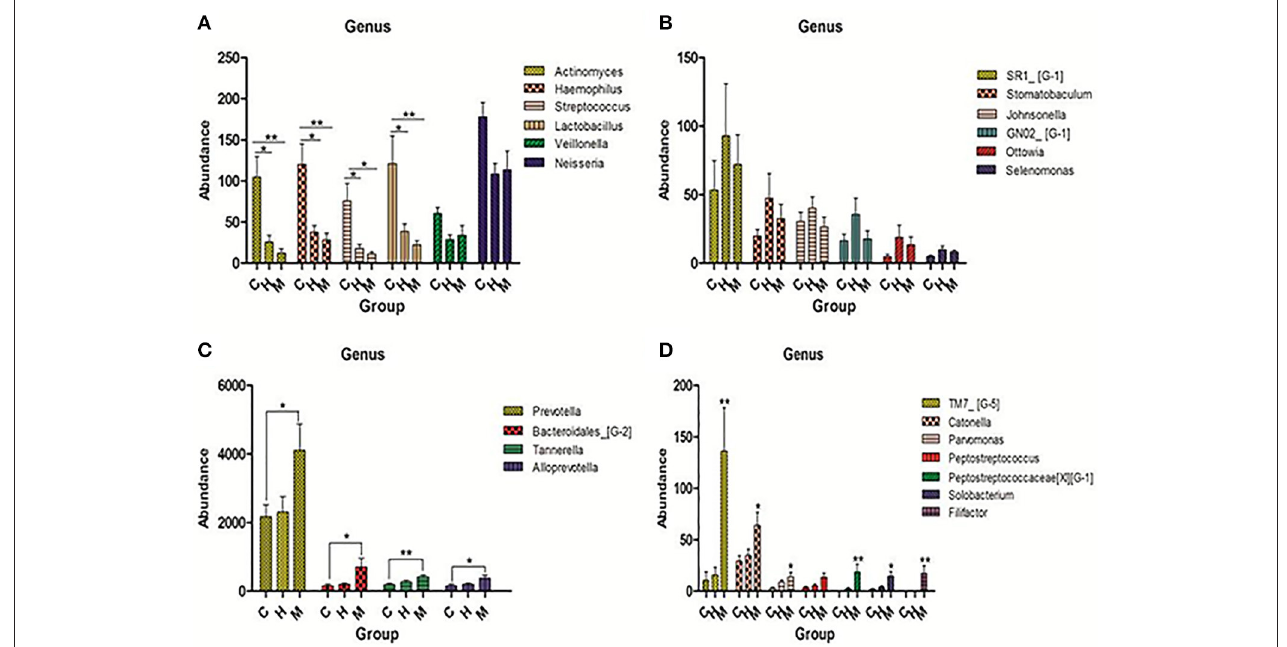
FIGURE 3 | Pick out 50 genera which were ranked top in the total genera and then analyzed the predominant members in each group. (A) Genera were abundant in caries group. (B) Genera were abundant in caries-free group. (C,D) Genera were abundant in mother group. The statistical methods of one-way ANOVA followed by